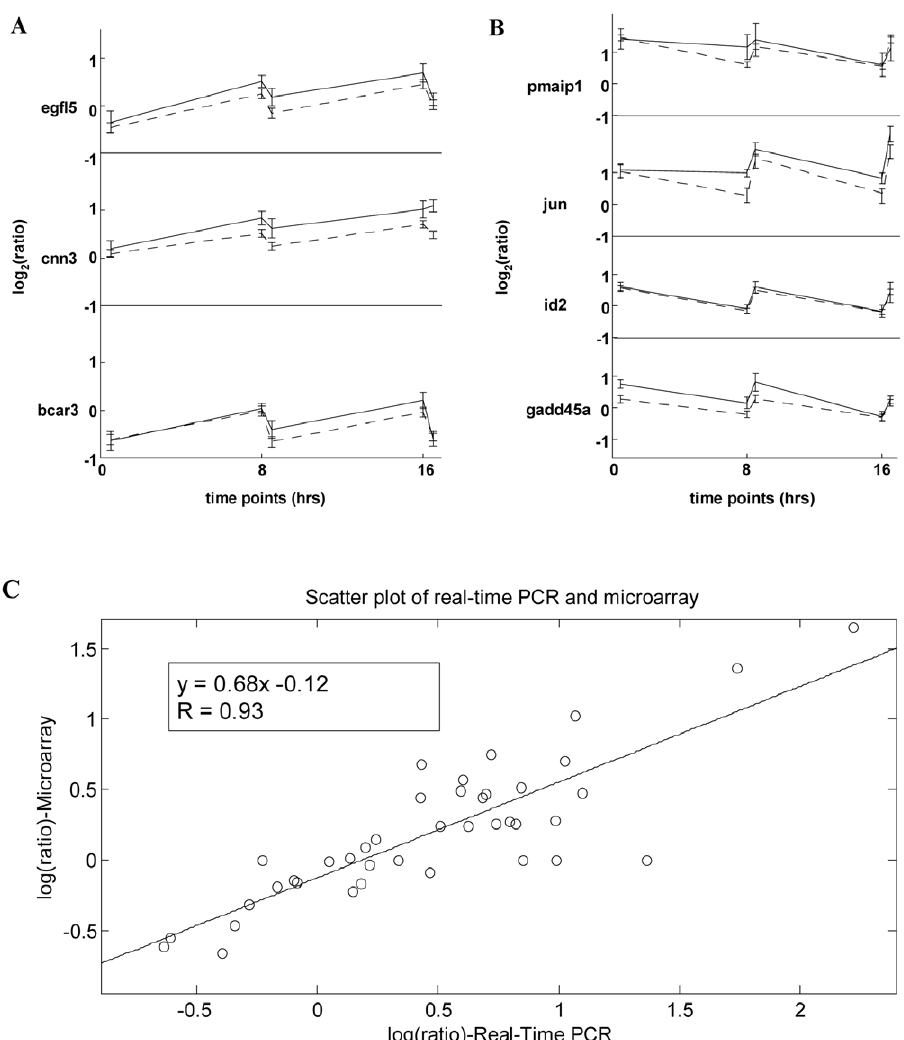
Figure 4. Comparison of microarray data with real-time PCR data. A and B ) Seven genes were chosen randomly from the set of genes with steady-state characteristics for this comparison. egfl5, cnn3, and bcar3 ( A ) exhibit immediate down-regulated responses, while pmaip1, jun, id2, and gadd45a ( B ) exhibit immediate up-regulated responses followed by relaxation. Solid and dash lines represent real-time PCR data and microarray data, respectively. The error bar of the microarray data indicates standard deviation estimated by the log linear model. The error bar of real-time PCR data is the standard deviation derived from three sets of CTs. C ) Scatter plot of real-time PCR results versus microarray data. The correlation coefficient, R is 0.93. The red line is a linear fit through all points. These results clearly demonstrate that even at the small fold change data points, these two sets of data agree very well. It also demonstrates the high reliability and resolution of our cDNA microarray system, which makes this kind of small perturbation study possible.